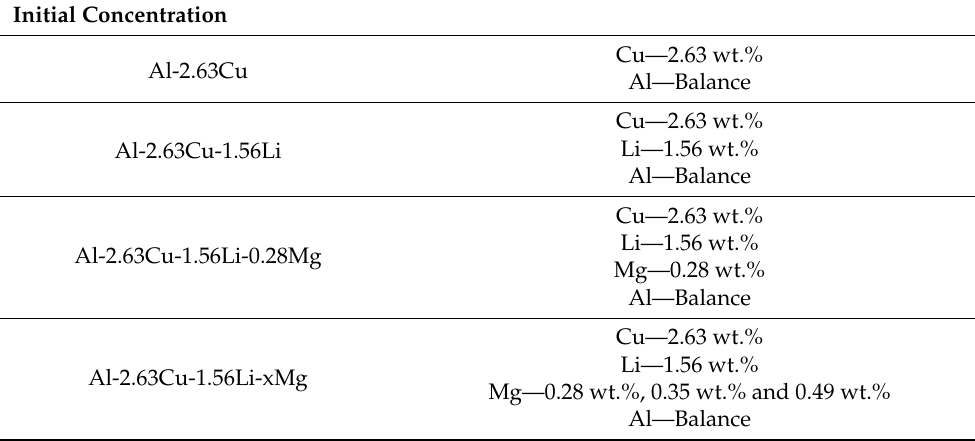
Table 3. The initial concentration used for Al–Cu, Al–Cu–Li, and Al–Cu–Li–Mg droplets